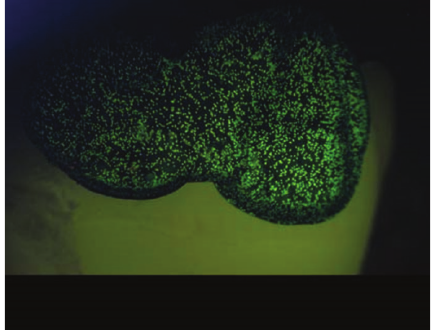
Figure 1: A low power SEM shows the random distribution of the beads on a tooth. Open areas without beads contribute to the random field and provide good imaging.